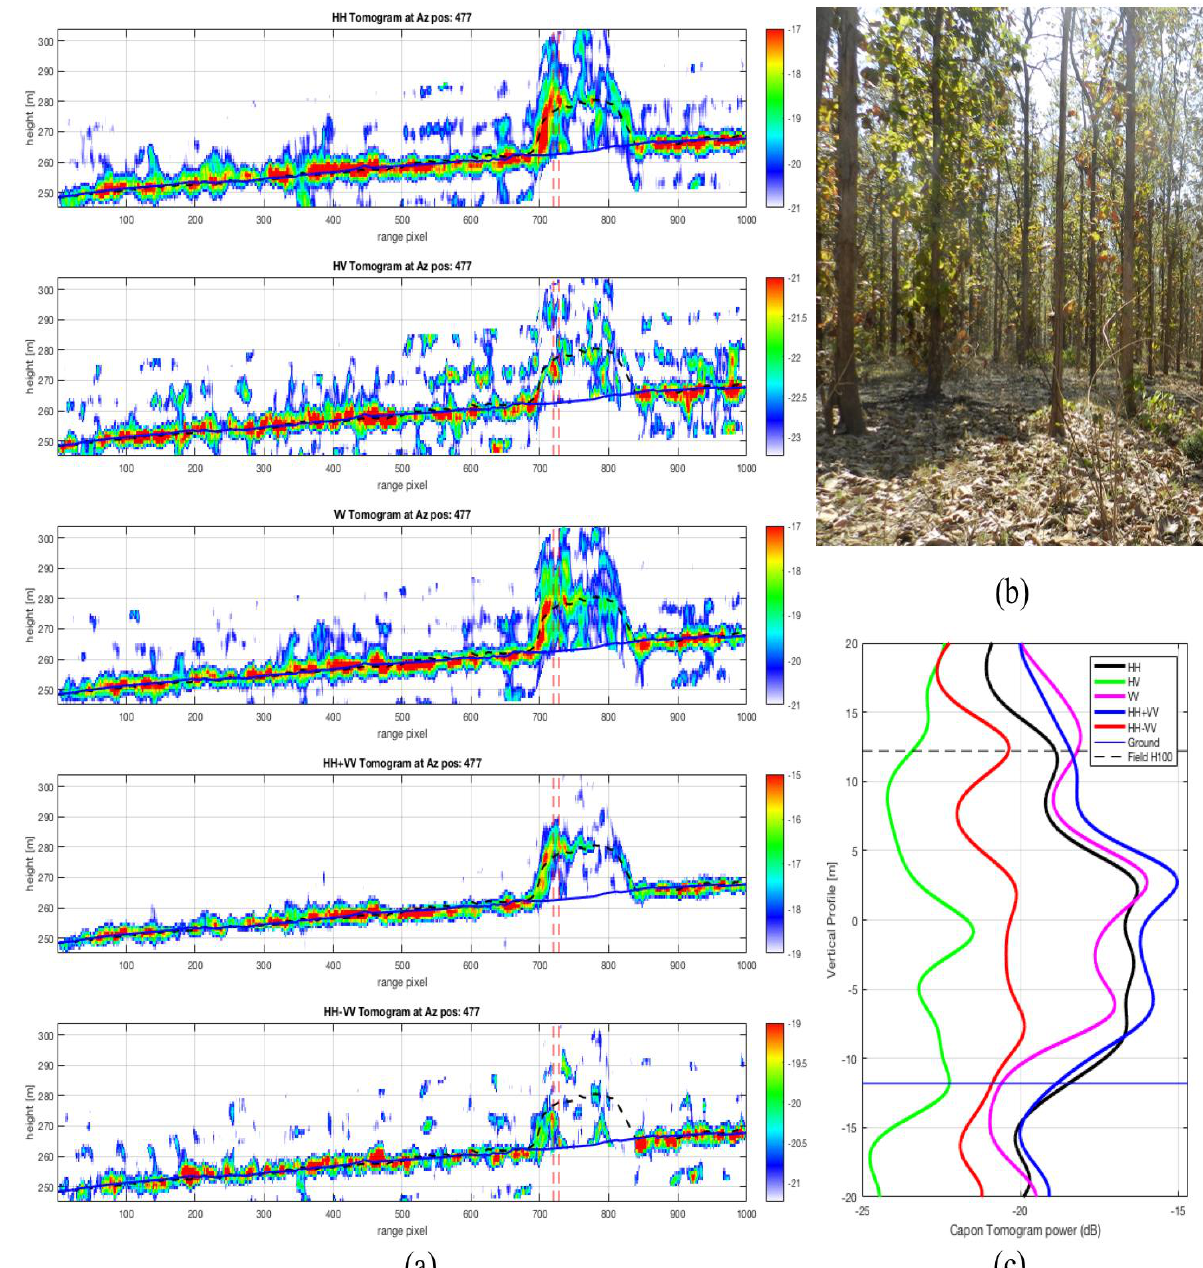
Figure 1 (a) Tomograms in 5 polarizations - HH,HV, VV, HH+VV and HH-VV over a Teak plantation in Haldwani forest range. Also shown are the (b) Field photograph captured in November 2015 and (c) the vertical profile of the field plot in the 5 polarizations. The legend describes the